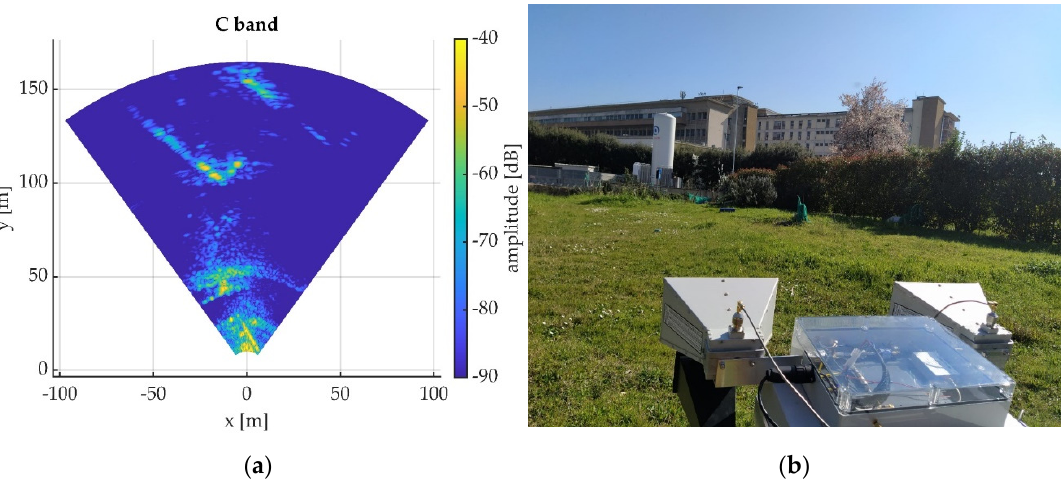
Figure 10. ( a ) Amplitude GBSAR image acquired in C-band of the illuminated urban area, in Florence, Italy; ( b ) a picture of the illuminated scene.